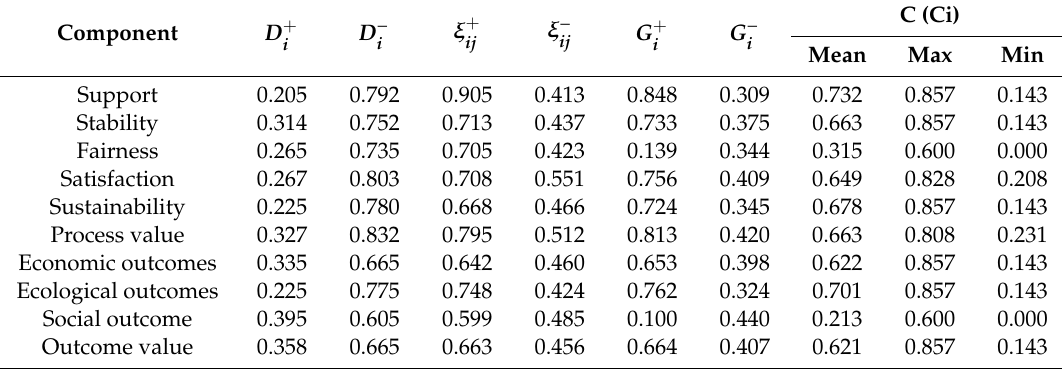
Table 3. The evaluation results of the GRA-TOPSIS in process and outcome dimension.